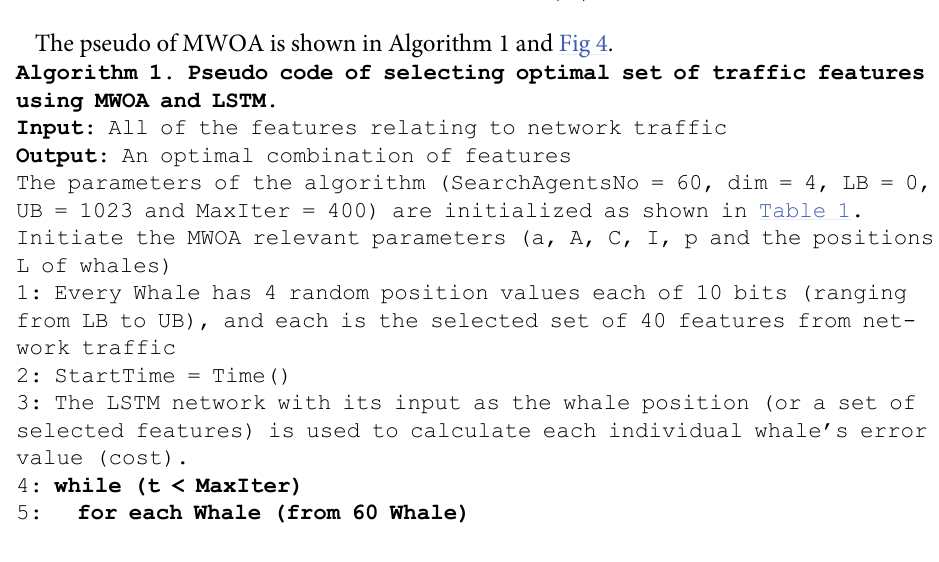
Algorithm 1. Pseudo code of selecting optimal set of traffic